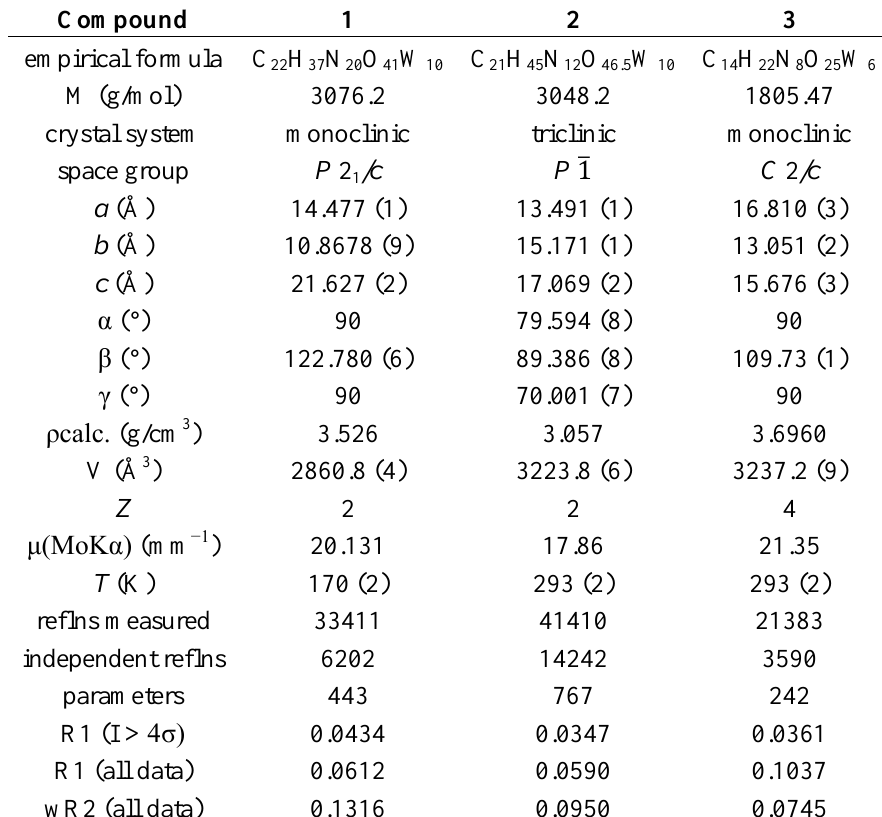
Table 1. Crystallographic data for 1 to 3